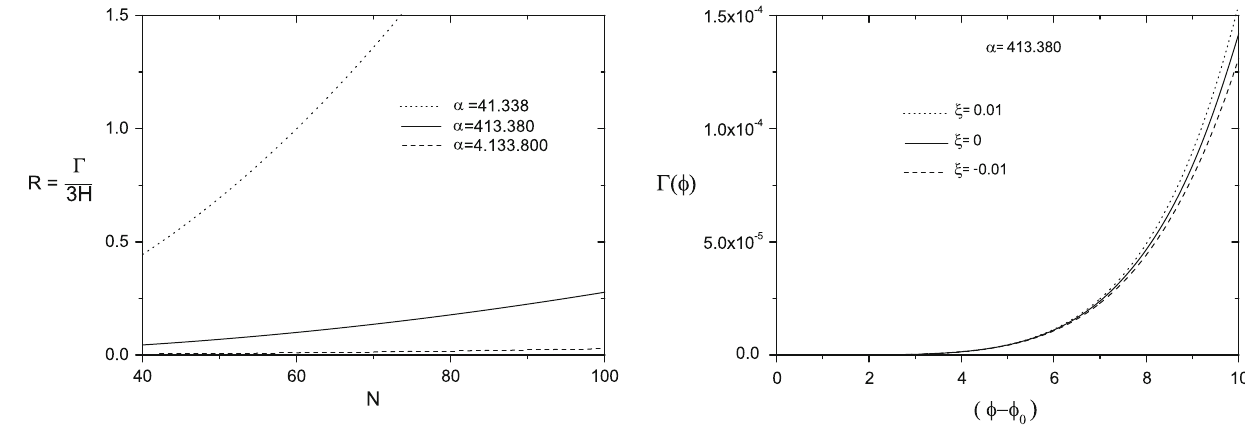
Fig. 1 The dependence of the ratio R = (cid:3) versus the number of dashed lines correspond to three different values of α (left panel). From 3 H e-folds N (left panel) and the dependence of the dissipation coeffi- Eqs. (44), (48) and (50) we plot (cid:3) = (cid:3)(φ) for three different values cient (cid:3) versus the scalar field (right panel) during the weak dissipative of ξ (cid:2) 0, in which we have fixed α = 413 . 380 (right panel). Also, in regime. From Eq. (40) we plot R = R ( N ) in which the dotted solid and these plots we have used C γ =